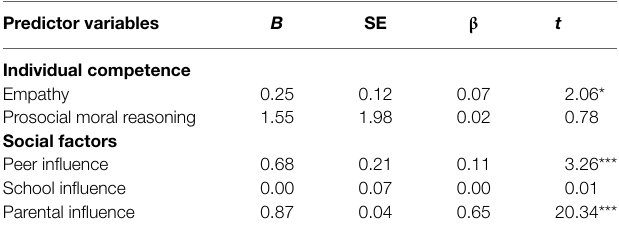
TABLE 5 | Prediction of prosocial behavior from individual competence and social influence factors ( N = 580) . Predictor variables